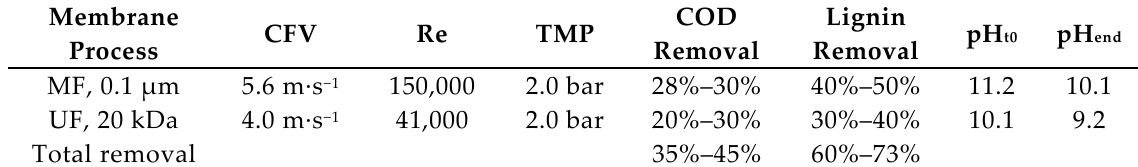
Figure 6. Effect of volume reduction on the COD retention efficiency of a ceramic 0.1-µm MF membrane. Table 5. Performance data for 0.1-µm and 20-kDa ceramic membranes in series.